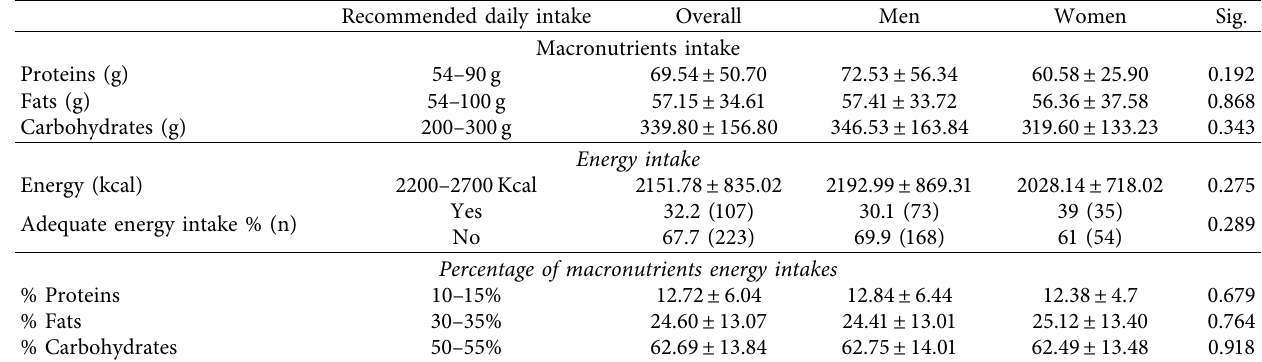
Table 8: Macronutrients and energy intake of the study